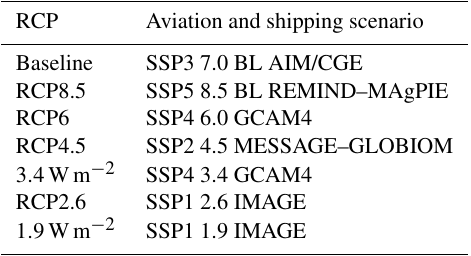
Table 3. Choice of SSP–CMIP6 bunker pathways to complement the RCPs and SSPv2 scenarios with CO 2 , N 2 O, and CH 4 emissions. CH 4 is only needed for the SSPv2 scenarios, as data are available for the RCPs. Baseline emissions are between RCP6 and RCP8.5 for most SSPs. GLOBIOM: GLObal BIOsphere